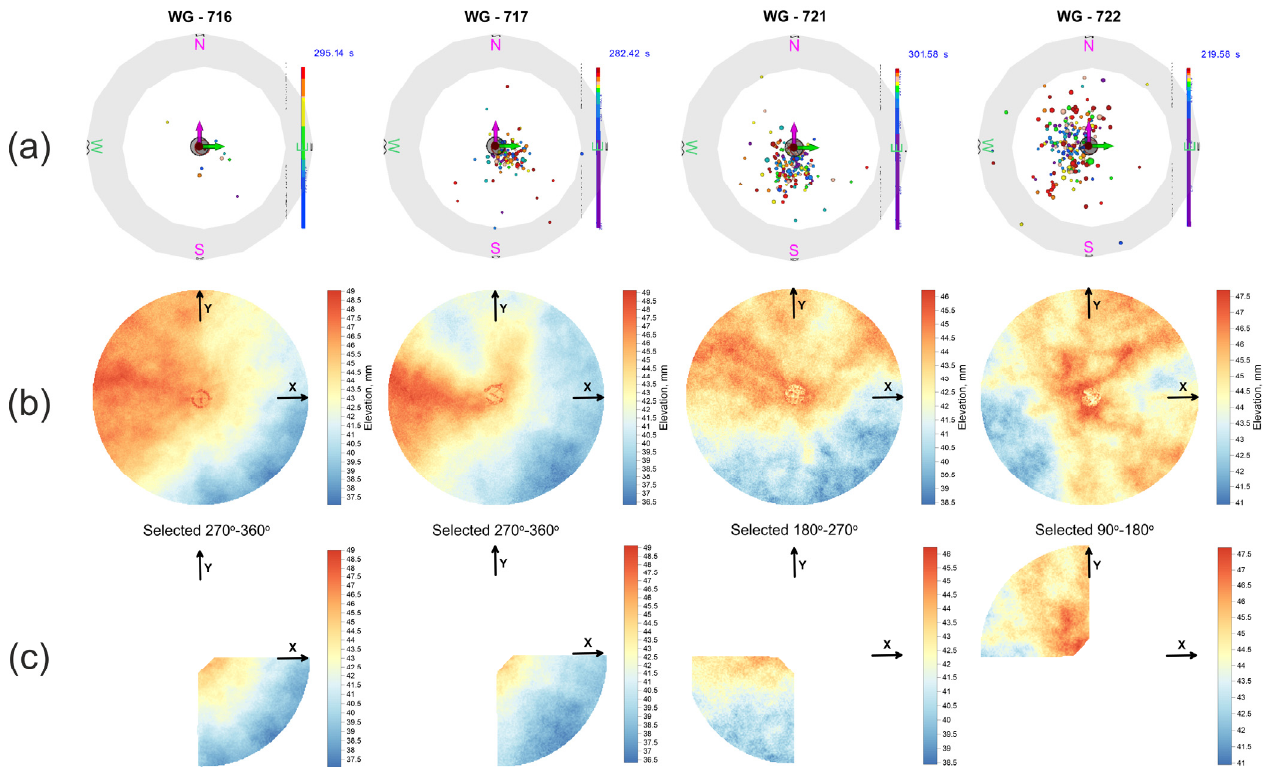
Figure 21. The top view on: ( a ) localizations of AE signals recorded during initial stage of HF propagation ( b ) 2D fracture surface maps of the samples and ( c ) sectors selected for the analysis of fracture topography.